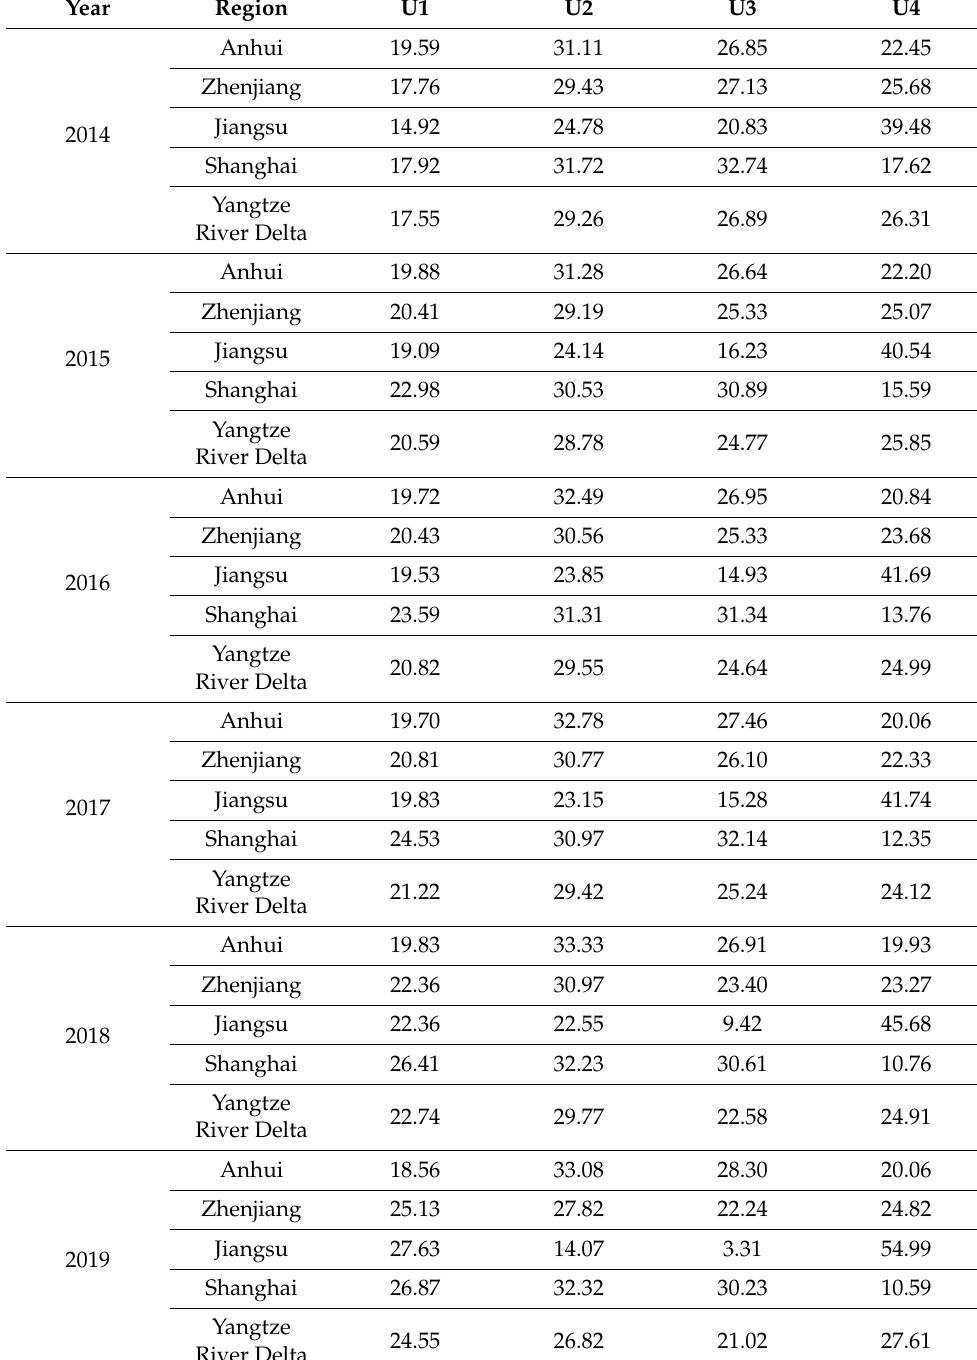
Table 6. Obstacle degree of the subsystem of the innovation EROB complex system in the